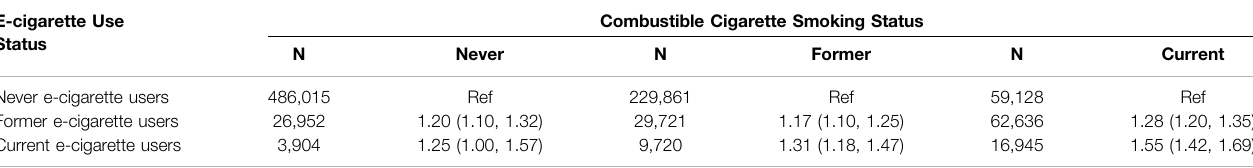
TABLE 4 | Association between E-Cigarette use and the risk of in fl ammatory arthritis diseases according to combustible-cigarette smoking among US adults. E-cigarette Use Status